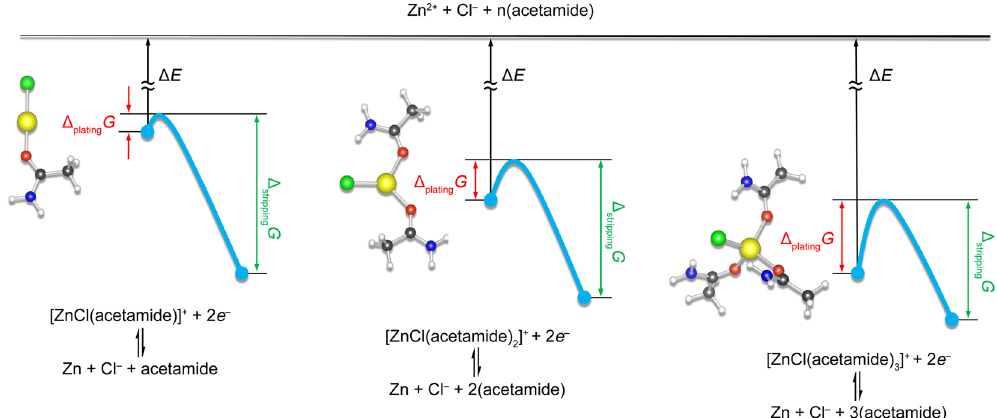
Figure 5. Schematic demonstration of the dissociation energy ( Δ E ) of Zn(II) complexes and activation energy of [ZnCl(acetamide)] + , [ZnCl(acetamide) 2 ] + and [ZnCl(acetamide) 3 ] + during electroplating ( Δ plating G ) and electrostripping ( Δ stripping G ) processes in the Zn eutectic